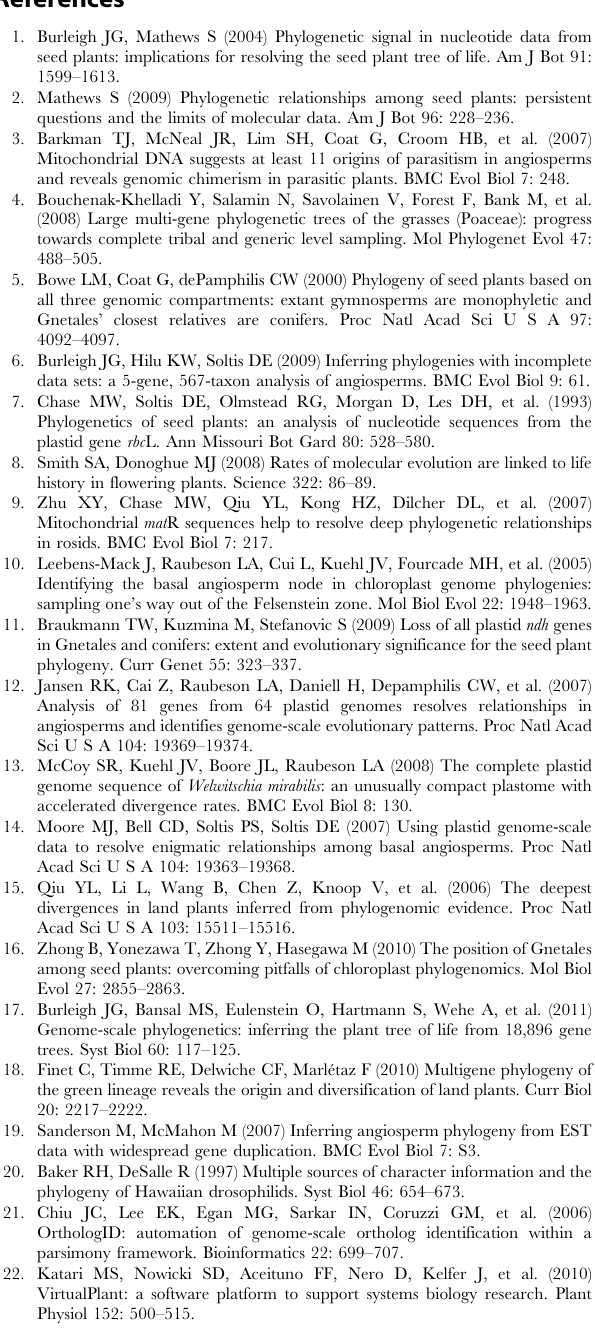
Table S6 Selection analysis results for the Euphorbia candidate genes. Values given for 13 genes whose amino acid sequence showed strong, positive PBS (PBS . 10) and belonged to the same MIPS